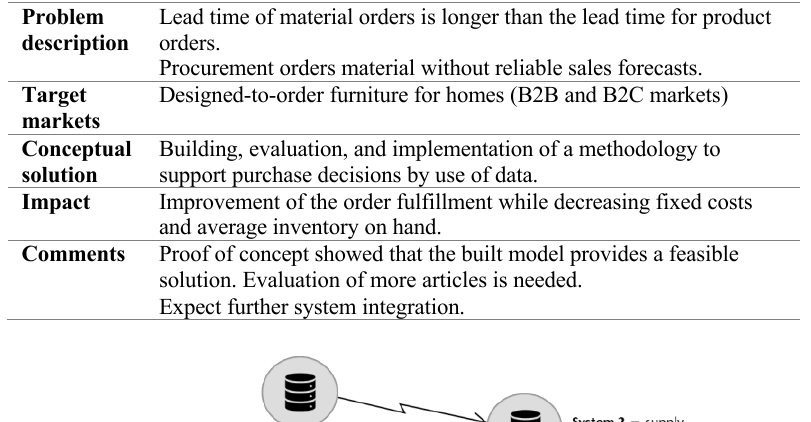
Table 3. Contextual description for case 2